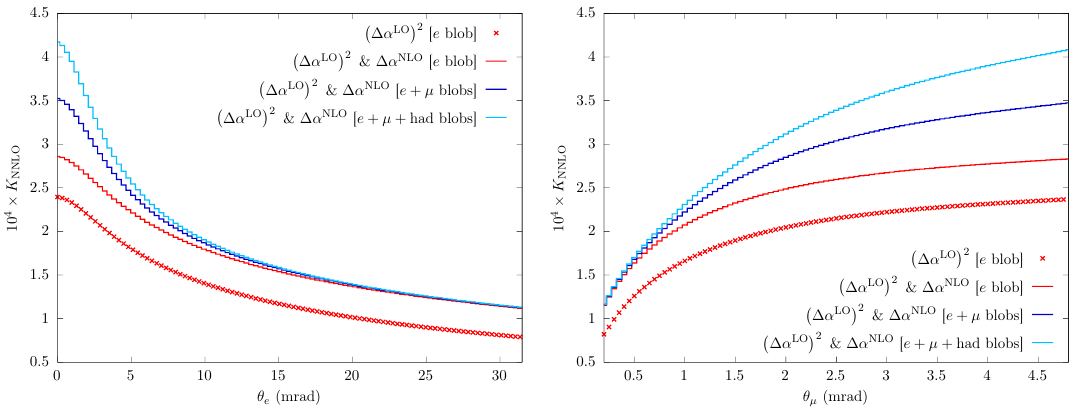
Figure 9. Left: differential K NNLO factor for the electron scattering angle, including the diagrams of figure 2. Right: the same as left panel, for the muon scattering angle.